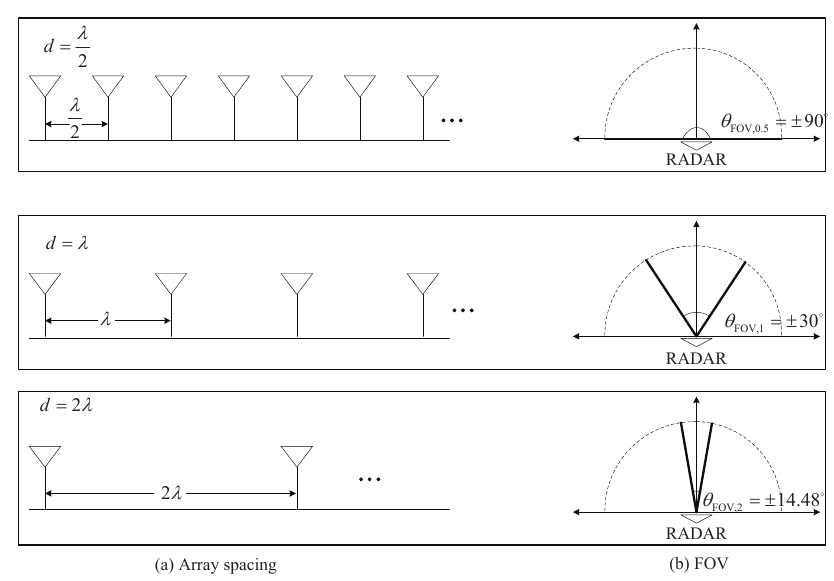
Figure 5. Schematic of relation between array spacing and